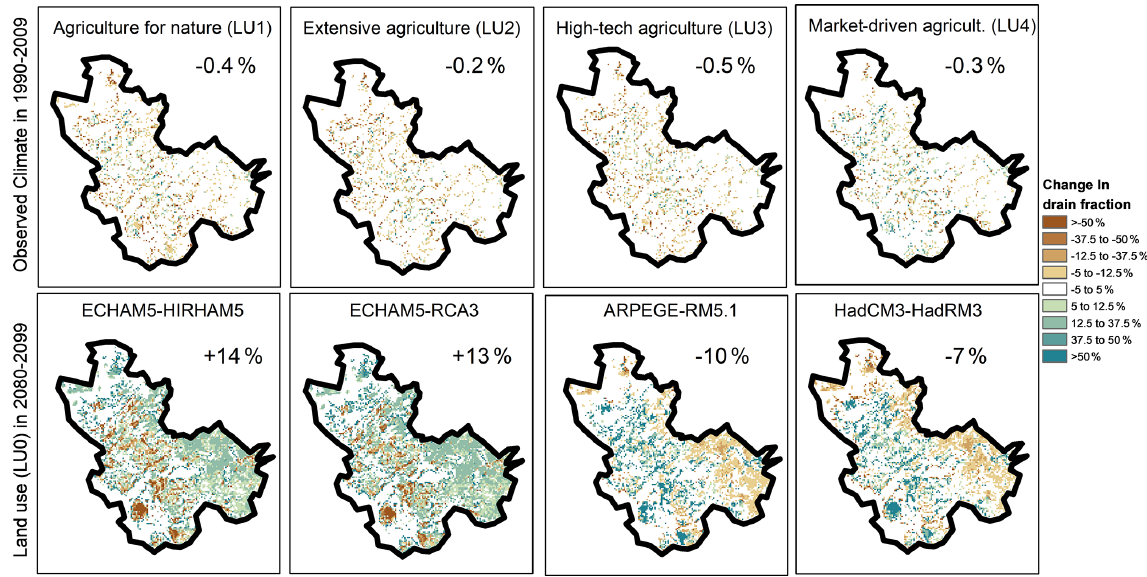
Figure 5. Changes in the drain flow fraction from the baseline (LU0) to the four land use scenarios (LU1–4) in the observational period (top row) and from the reference period to the future period for four climate models using LU0 (bottom row). The drain flow fraction is defined as the drain flow divided by net precipitation. Green colours indicate that a larger percentage of the net precipitation is channelled into the drains for the future. The number in the upper right corner indicates the relative change in drain flow fraction from reference period to future period. The corresponding percentage of drain flow in the baseline scenario is